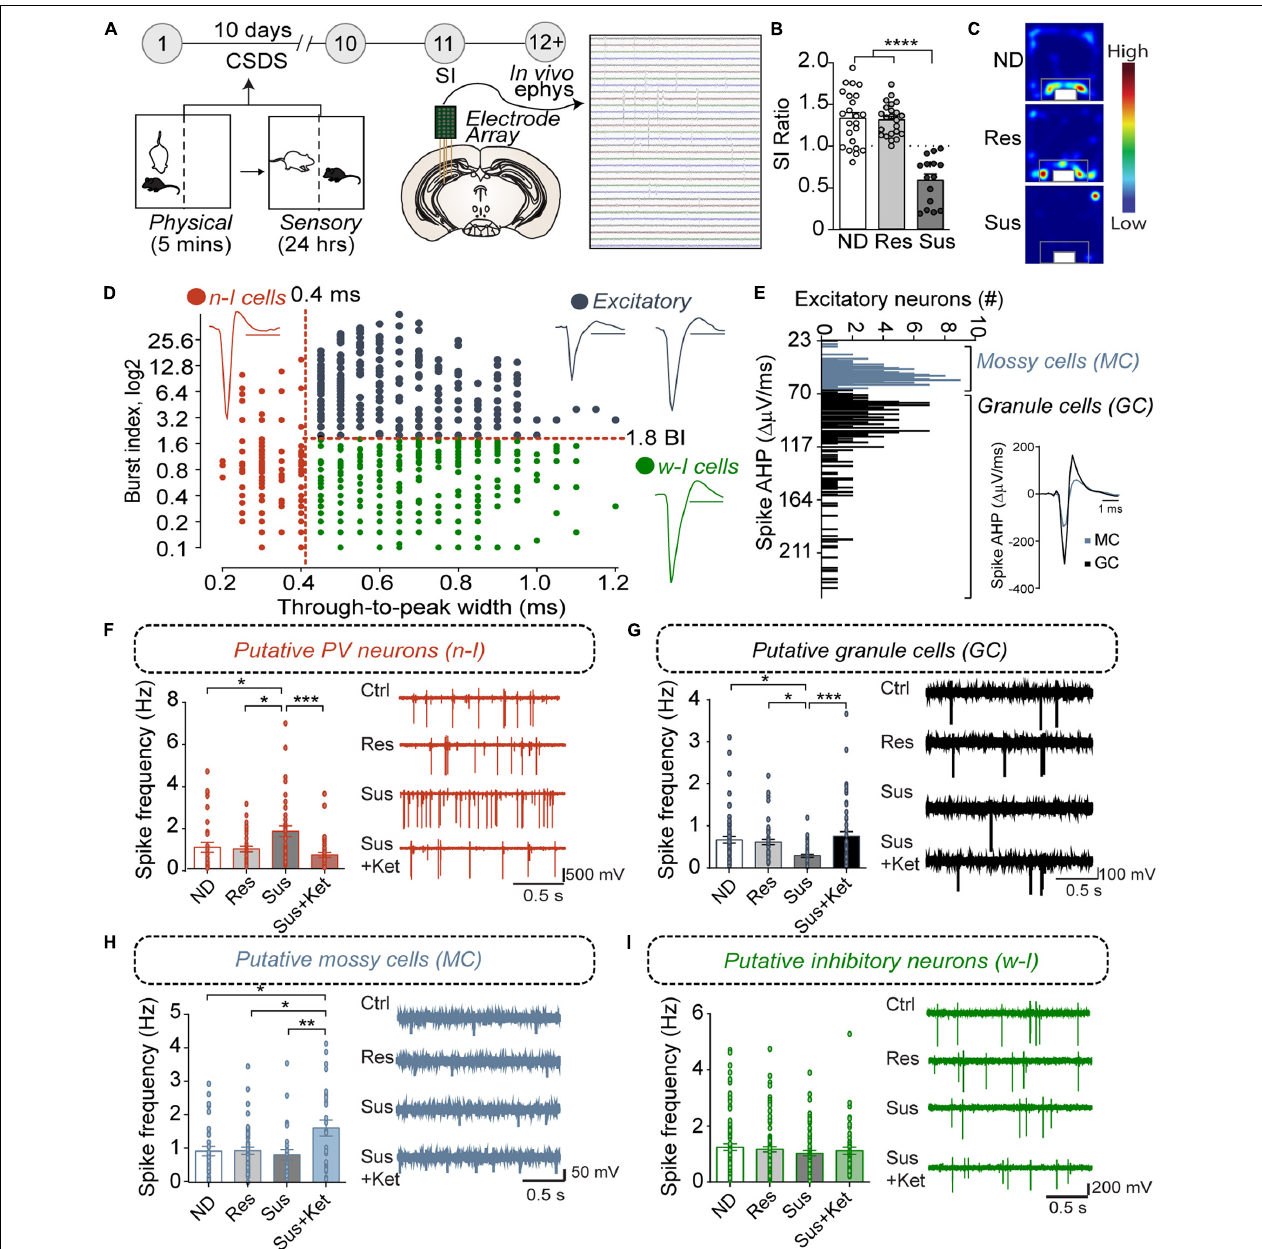
FIGURE 1 | PV vDG neuron activity is altered by CSDS and associated with behavioral outcome. (A) Diagram and timeline of CSDS and intra-vDG electrophysiological recordings. (B) Representative animals depicting separation of animals into non-defeated control (ND), resilient (Res, SI ratio ≥ 1), and susceptible (Sus, SI ratio < 1) groups [one-way ANOVA, Non-defeated ( n = 23), Res ( n = 23) and Sus ( n = 15)]. (C) Example heatmaps displaying time spent in the SI arena with caged aggressor. (D) All neurons detected ( n = 772) went through a first stage classification based on the through-to-peak latency and burst index (BI) to distinguish putative excitatory cells (black dots, n = 336, BI > 1.8), narrow-waveform putative PV neurons (red dots, n = 142, latency ≤ 0.4 ms) and wide-waveform putative interneurons (green dots, n = 294, latency > 0.4 ms). Scale bars for the representative waveforms represent 1 ms. (E) Excitatory neurons were further classified in putative mossy cells ( n = 133, AHP < 70) and putative granule cells ( n = 203, AHP > 70) based on the bimodal distribution of the AHP current, measured from the first derivative of the spike. (F–I) Histograms show frequency (mean ± SEM) of the putative neuronal types analyzed in the respective experimental groups. Each black dot represents a neuron. (F) Susceptibility is associated with an increase in PV neuron spike frequency that is reversed by Ketamine ( n = 31/7 (neurons/mice) ND mice; 36/7 resilient mice, 37/5 susceptible mice, and 38/3 for susceptible mice treated with ketamine). (G) Susceptibility is associated with decreases in GC spike frequency that is reversed by Ketamine [ n = 61/7 (neurons/mice) ND mice, 47/7 resilient mice, 41/5 susceptible mice, and 54/3 susceptible mice treated with ketamine]. (H) Ketamine increases MC spike frequency [ n = 31/7 (neurons/mice) ND mice, 49/7 for the resilient mice, 27/5 for the susceptible mice, and 26/3 susceptible mice treated with ketamine. (I) CSDS or Ketamine did not alter spike frequency in other inhibitory neurons ( n = 85/7 (neurons/mice) ND mice, 97/7 resilient mice, 62/5 susceptible mice and 50/3 susceptible mice treated with ketamine). * p < 0.05, ** p < 0.01, *** p < 0.001, one-way ANOVA with Bonferroni’s post hoc comparison.